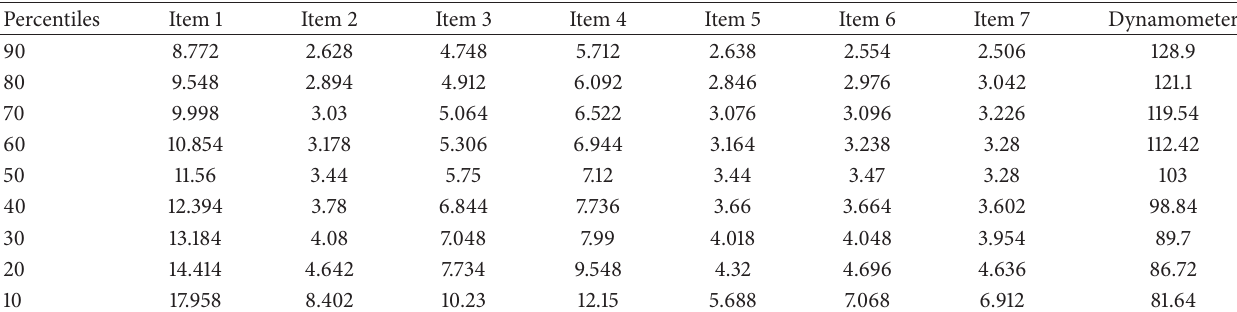
Table 23: 𝑛 = 17 , males, 20–94, dominant hand, educational instruction: